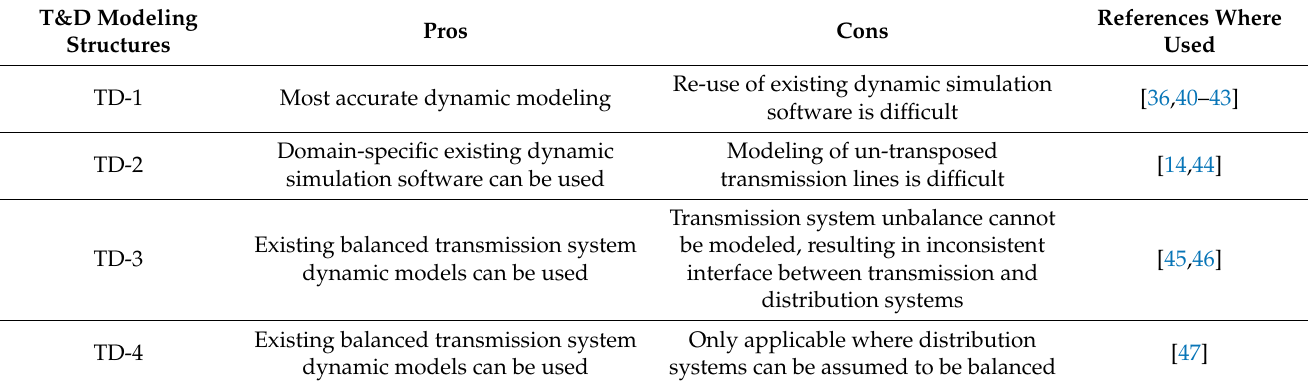
Figure 5. Four integrated T&D modeling structures for dynamics used in literature. Table 3. References that used the four T&D dynamic modeling structures.